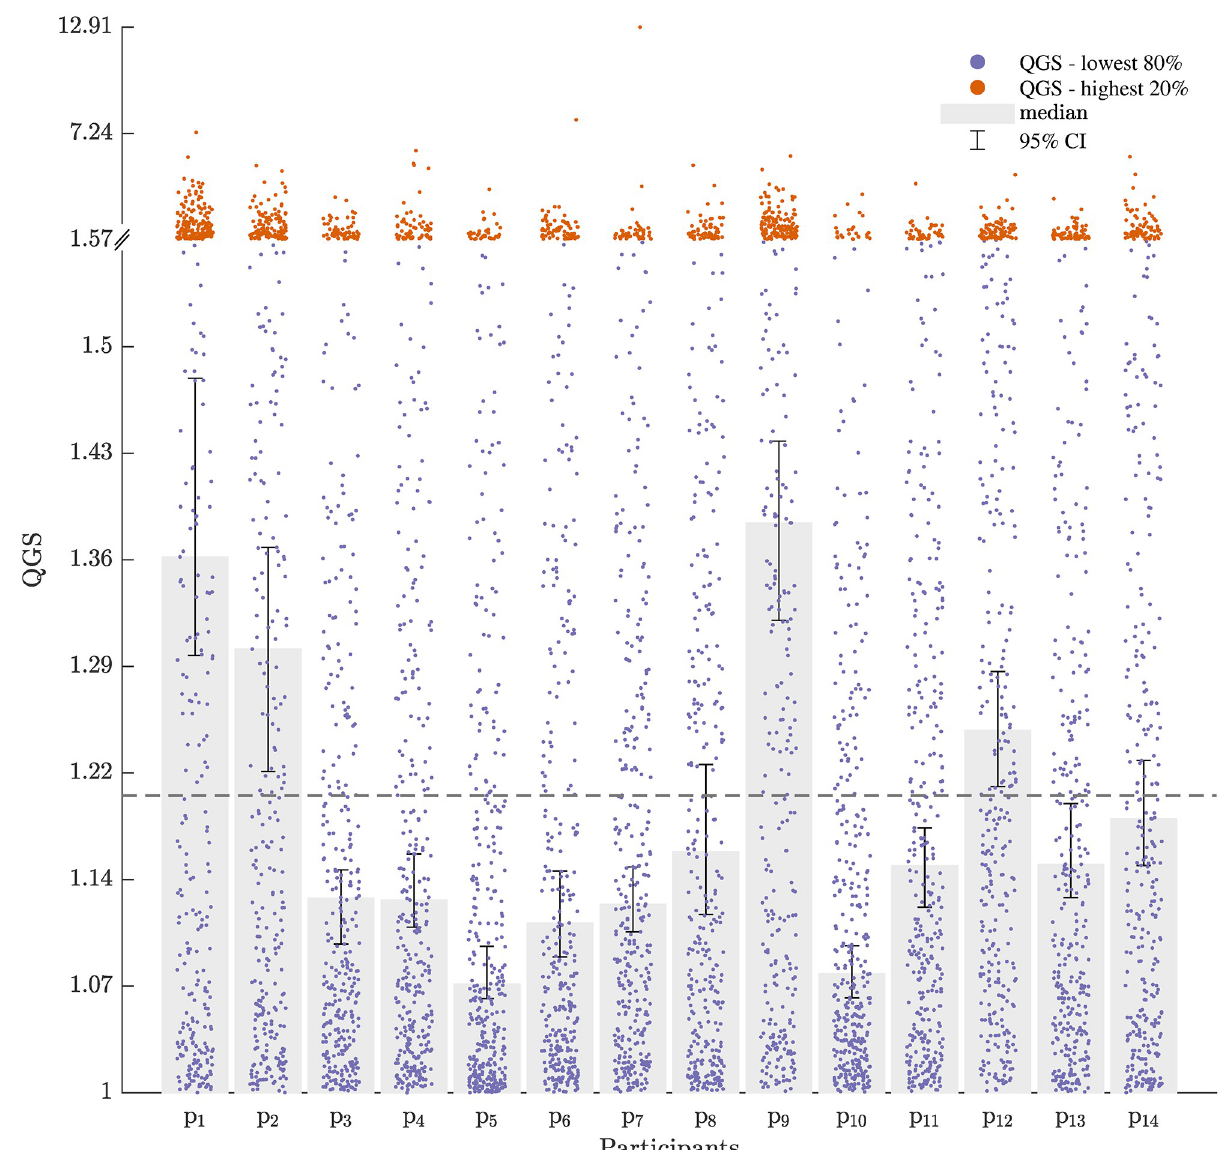
Fig 6. Median QGS and 95% bootstrap CI. Most of the participants performed geodetic hand rotations as indicated by the low 95% CI of the median QGS for eight of the fourteen participants (p 3 —p 7 , p 10 , p 11 and p 13 ). Yet, four participants deviated largely from geodesics (p 1 , p 2 , p 9 and p 12 ), while the rest gave indecisive results (p 8 and p 14 ). For visualization purpose, the lowest 80% of all scores are scattered in blue along 80% of the vertical axis, and the highest 20% of all scores are scattered in orange along the remaining 20% of the vertical axis. While both ranges are linearly scaled, the gap between values is different. The gray bars start from QGS = 1 (the lower limit of the region of interest), and end at the median of the scores of all trials for each participant. The error bars mark the bootstrap 95% CI for the median. The dashed gray line at QGS = 1.2 is the upper limit of the region of interest.